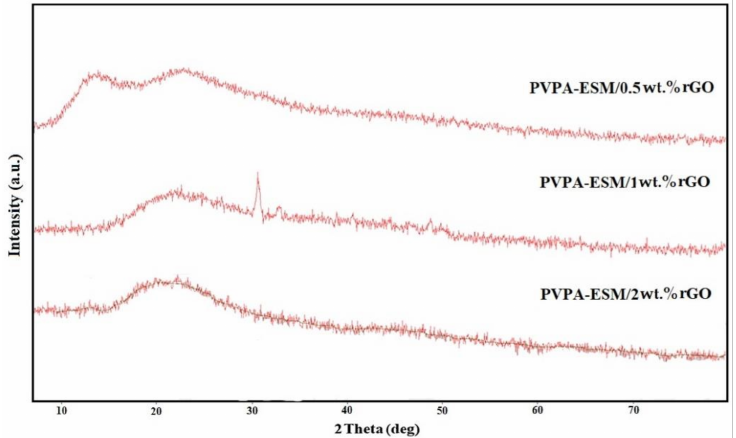
Figure 4. X–ray diffraction patterns of the electrospun PVPA–ESM/xwt.%rGO nanofibers (x = 0.5, 1 and 2